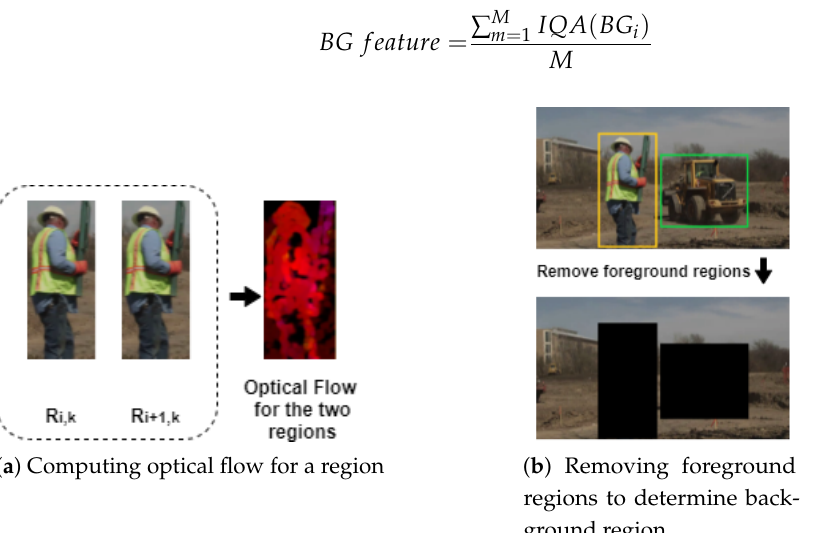
Figure 2. ( a ) Shows how to get the motion feature for the foreground region; and ( b ) defines the background region.